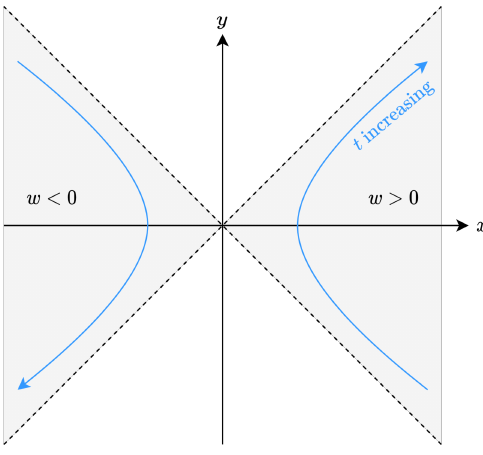
Figure 5 . Plot showing the shaded regions | x | > | y | , where the Hamiltonian (C.5) is valid. The blue arrows indicate increasing t = tanh − 1 ( y/x ) . By gluing this solution along | x | = | y | with the one in the | y | > | x | region, we arrive at the solution